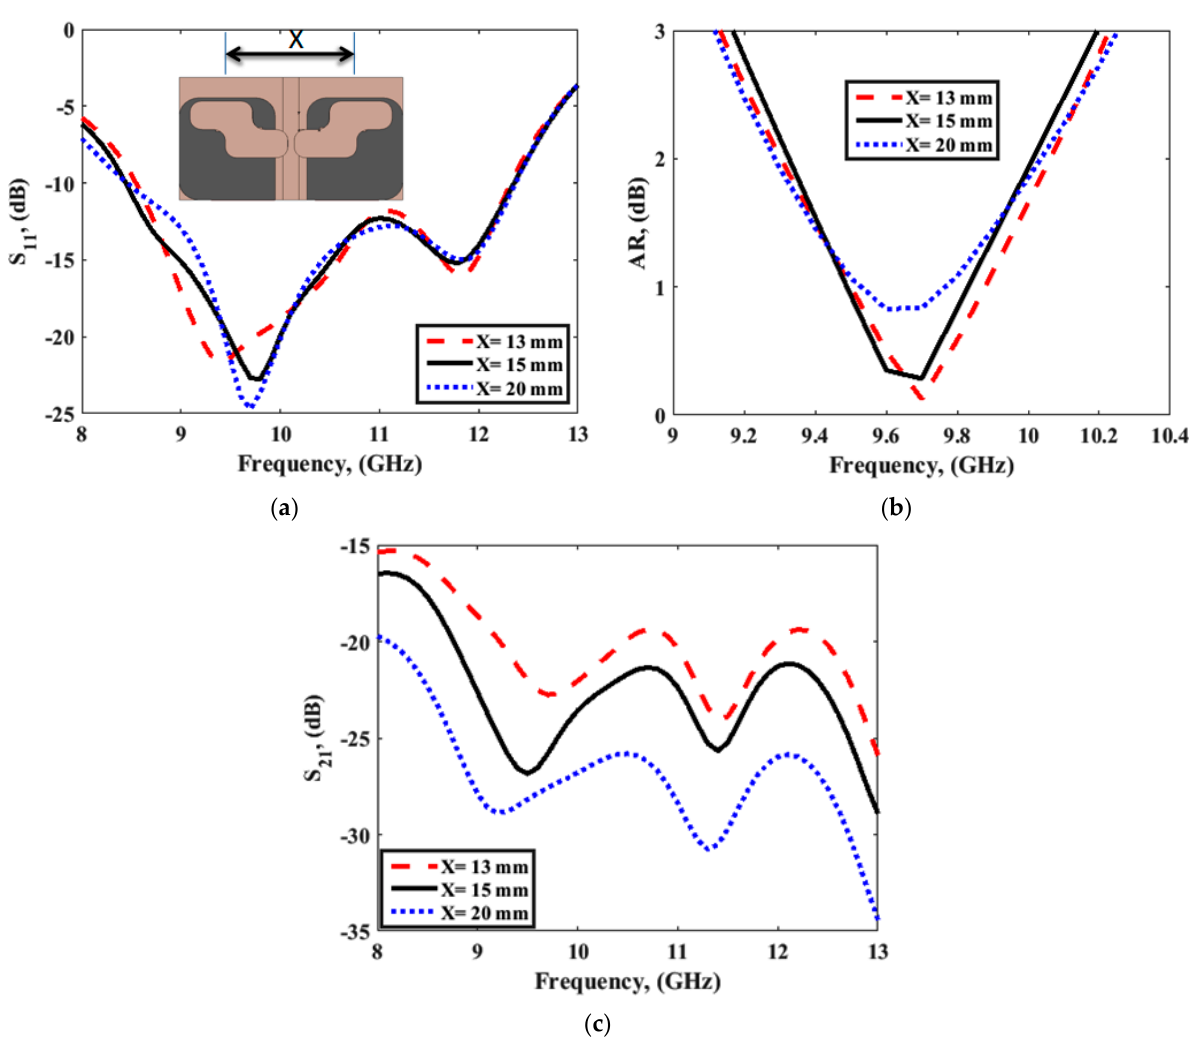
Figure 8. ( a ) S 11 , ( b ) AR, and ( c ) S 21 parameter with separation between the DR antennas with a slot in the ground.